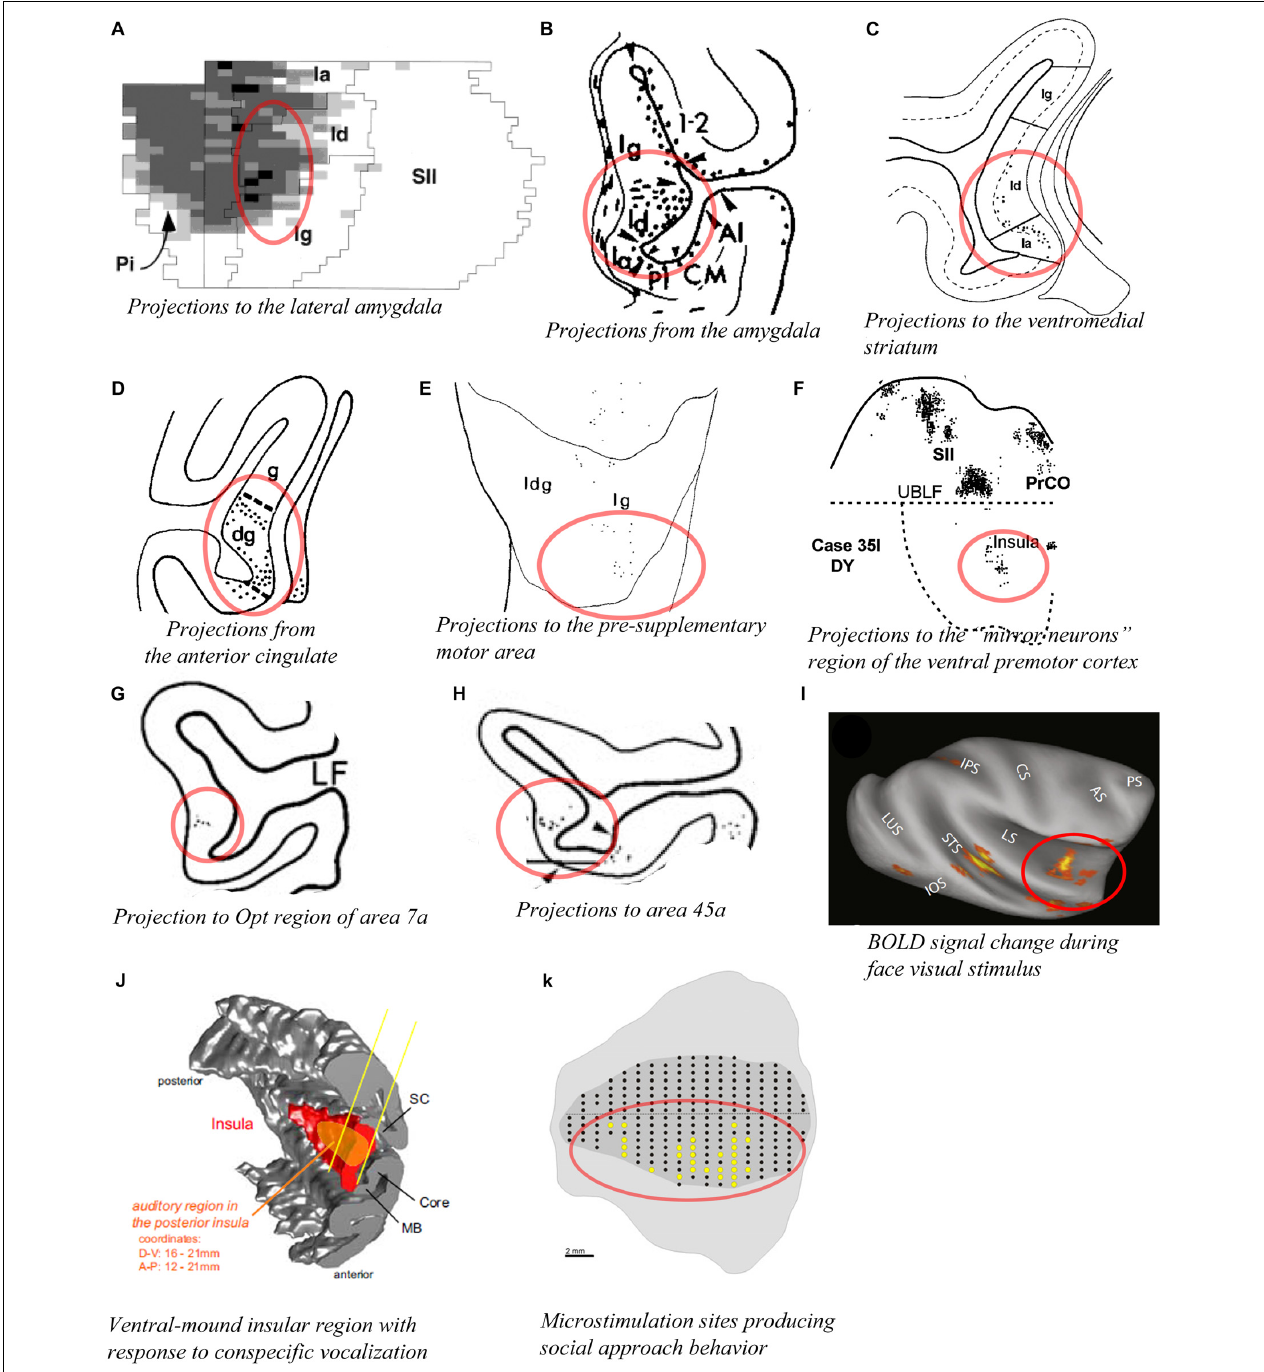
FIGURE 7 | Connectivity of the mound and ventral dysgranular areas of the macaque insula. In all panels, the regions of labeling in the mound and ventral dysgranular regions of the insula are denoted with a red circle. (A) Flat map plot of fluorescent retrograde labeling in the insula in case M28-92R with an injection of fast blue in the intermediate division of the lateral nucleus. In the flat map, up is rostral and right is dorsal (Stefanacci and Amaral, 2000). (B) Coronal plot of anterograde labeling in the insula in case FCP-2 with an injection of tritiated amino acids in the amygdala (Amaral and Price, 1984). (C) Coronal plot of retrograde labeling in the insula in case MS14 with an injection of WGA-HRP in the ventromedial portion of the striatum (Chikama et al., 1997). (D) Coronal plot of anterograde labeling in the insula in case 2a with an injection of TAA in the anterior cingulate cortex (Mufson and Mesulam, 1982). (E) Flat map plot of fluorescent retrograde labeling in the insula in case 4l with an injection of fast blue in the pre-supplementary motor area. In the flat map, up is dorsal and right is posterior (Luppino et al., 1993). (F) Flat map plot of fluorescent retrograde labeling in the insula in case 35l with an injection of diamidino yellow in the “mirror neuron” sector of the